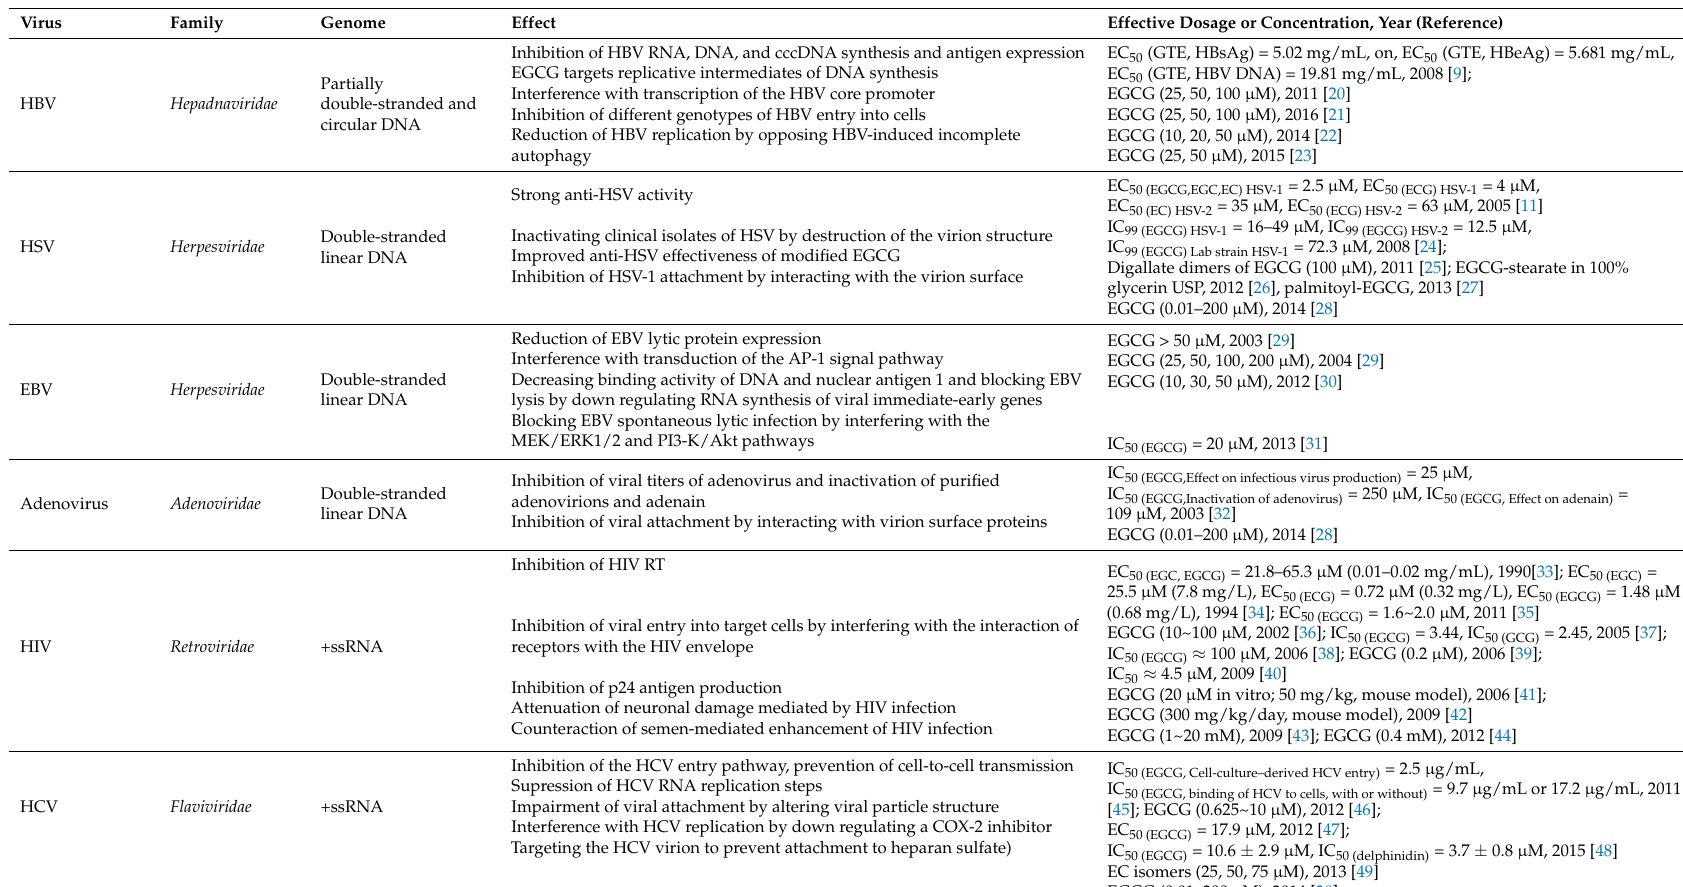
Table 1. Inhibitory effects of viruses by green tea